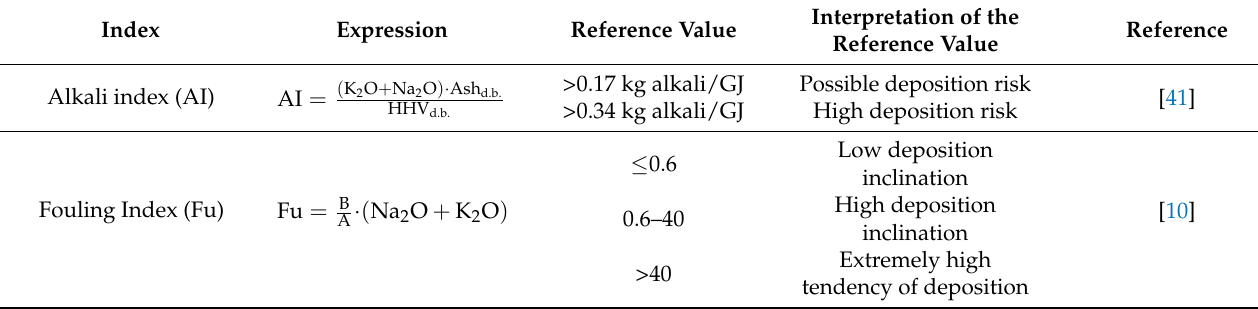
Table 5. Predictive indices for deposition.